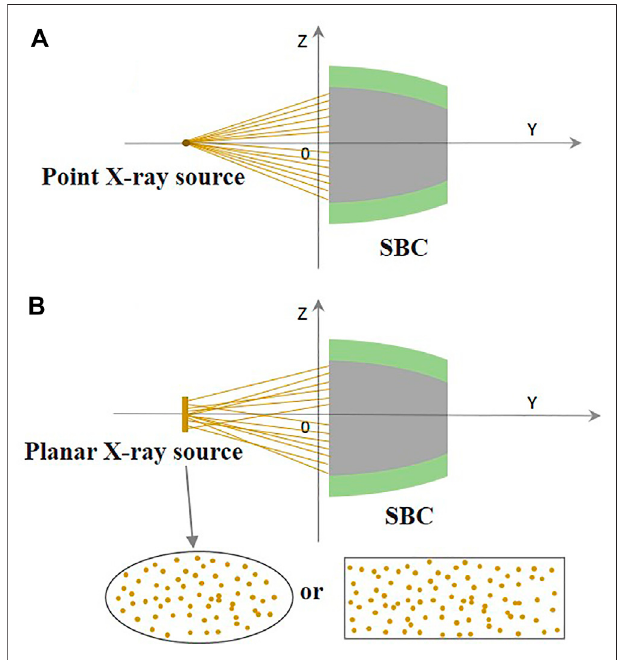
FIGURE 3 | Flow chart for simulating the SBC.